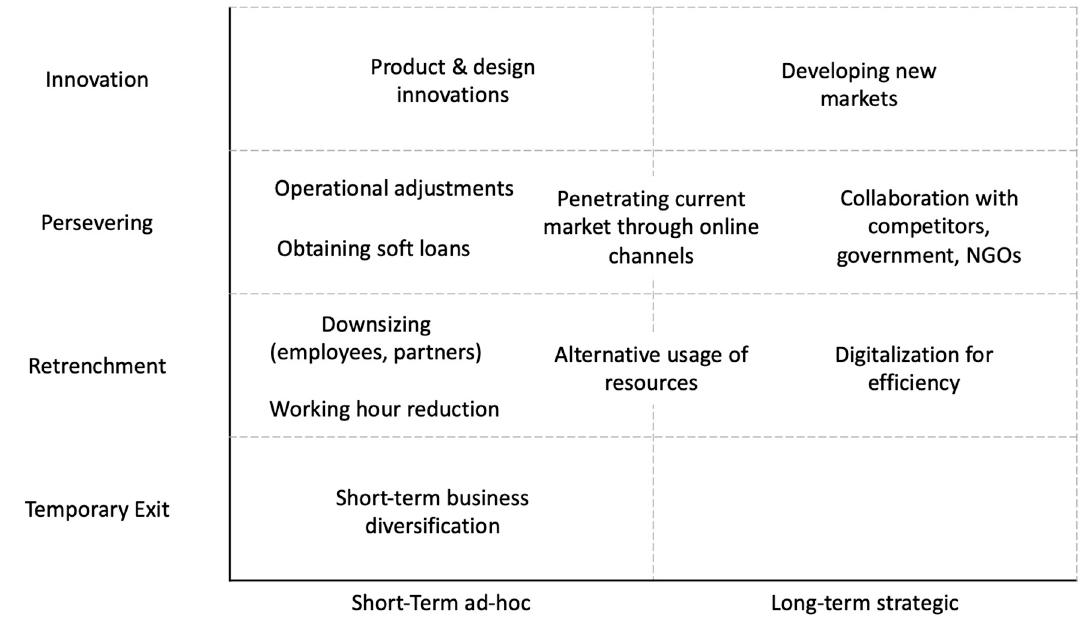
Figure 2. Batik SMEs’ Strategies in Coping with the Pandemic.